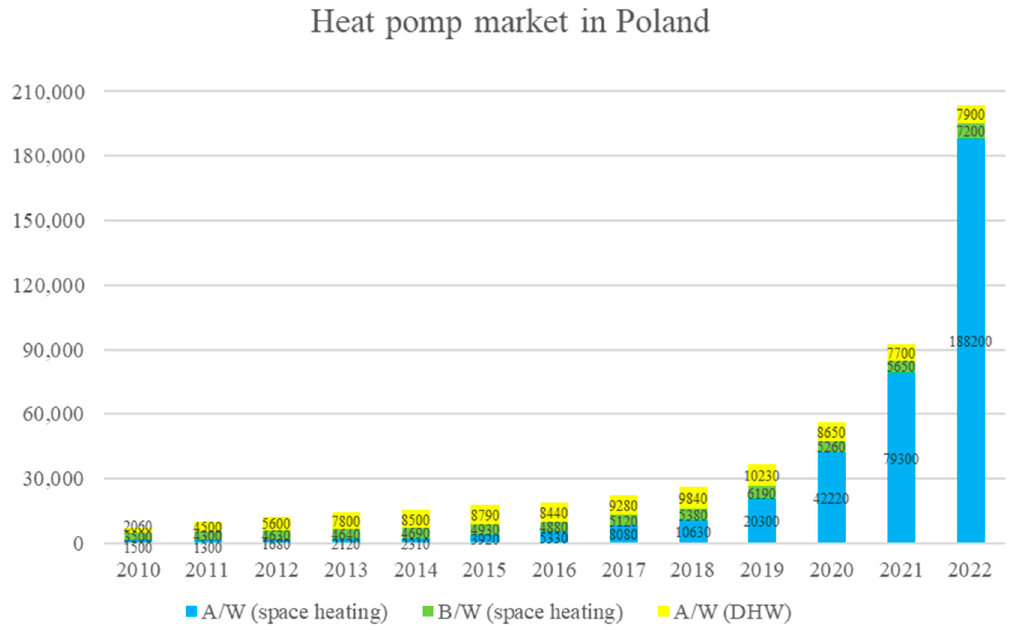
Figure 4. Development of the heat pump market in Poland in last 13 years (A/W—air-to-water for space heating; B/W—brine-to-water for space heating; A/W (DHW)—air-to-water for Domestic Hot Water heating).